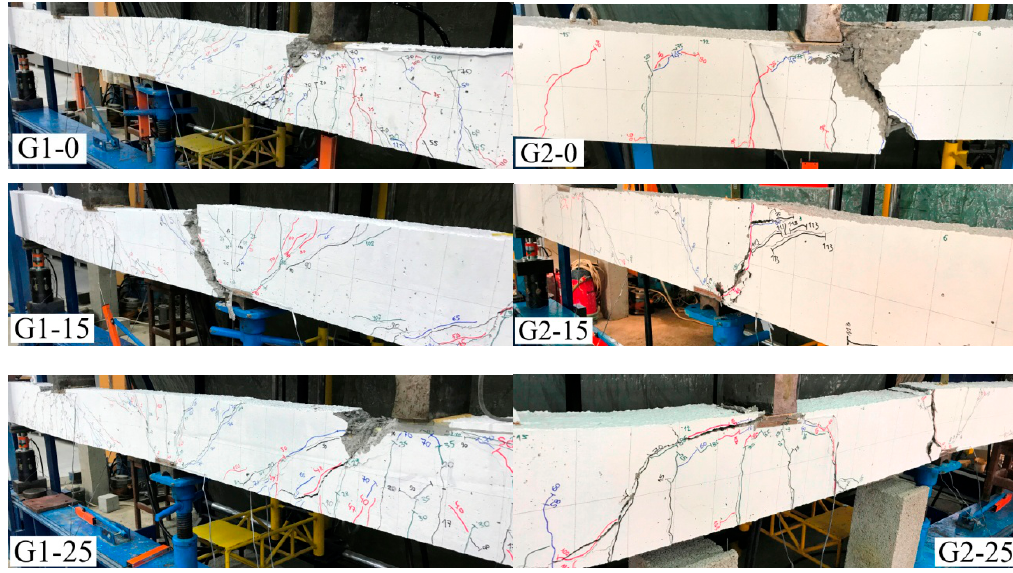
Figure 4. Crack patterns of experimental beams at failure (P—load at failure).